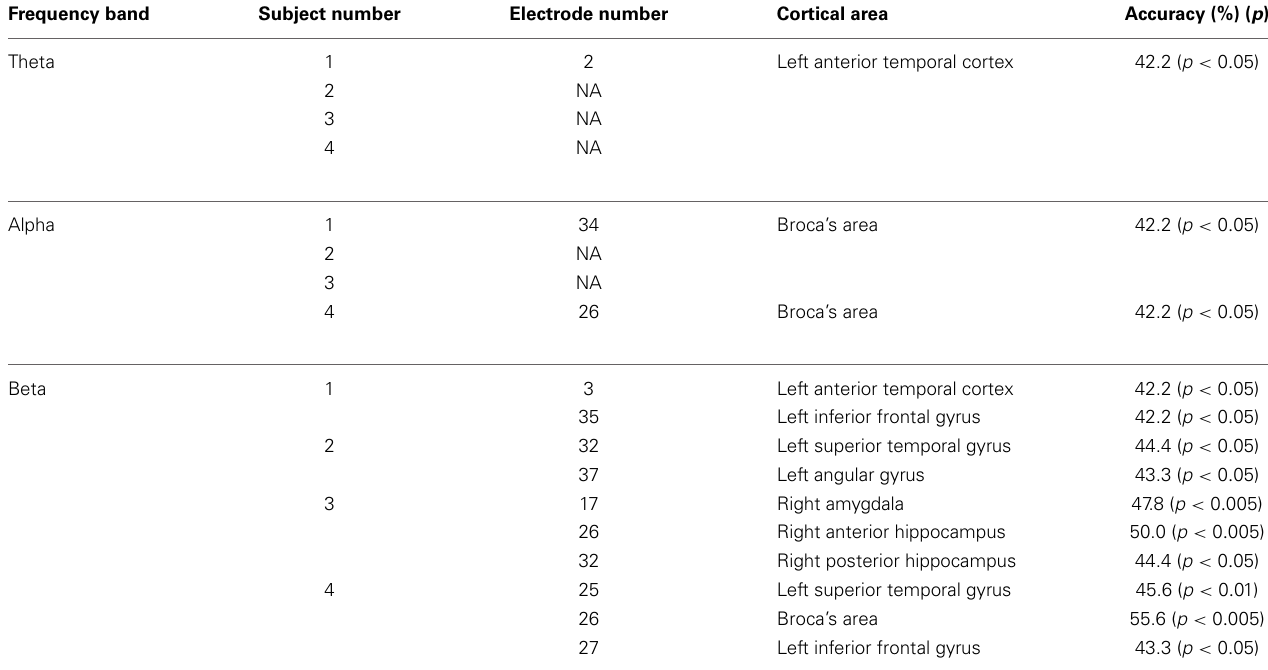
Table 5 | Cortical areas showing significant decoding accuracies in use of the theta, alpha, and beta power spectra. Frequency